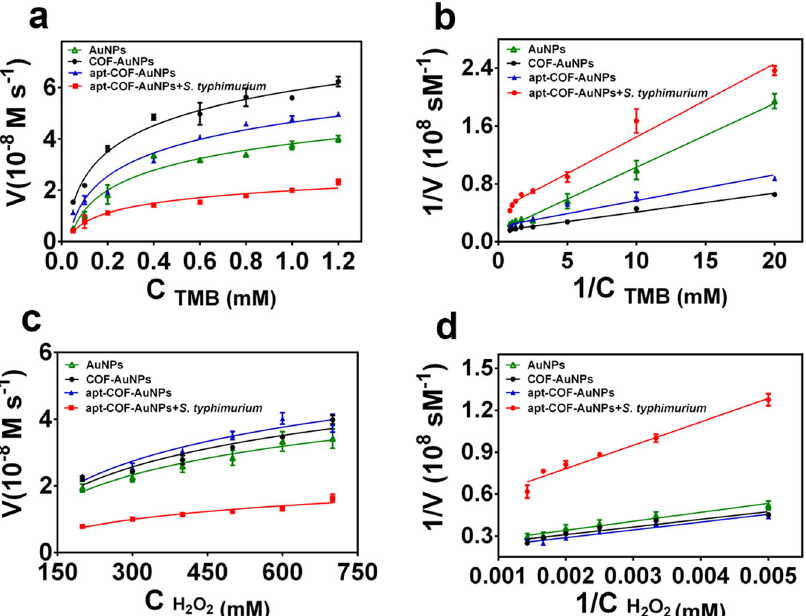
Fig. 4 Catalytic kinetics analysis. a Steady-state kinetic assay and b double reciprocal plots of activity of AuNPs, COF-AuNPs, apt-COF-AuNPs, and apt-COF-AuNPs + S. typhimurium . The concentration of H 2 O 2 was 2 M and the TMB concentration was varied. c Steady state kinetic assay and d double reciprocal plots of activity of AuNPs, COF-AuNPs, apt-COF-AuNPs, and apt-COF-AuNPs + S. typhimurium . The concentration of TMB was 2 mM and the H 2 O 2 concentration was varied. Error bars represent the standard deviation of three